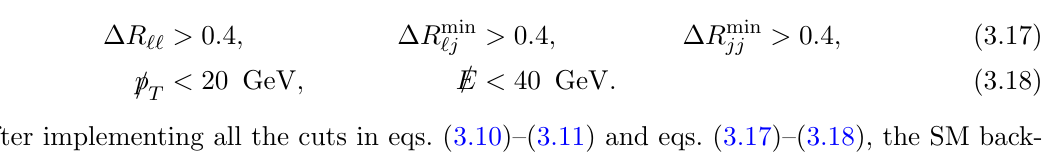
Figure 10 . Total cross section for the process e + e (cid:0) ! N(cid:22) (cid:6) W (cid:7) ! (cid:22) (cid:6) (cid:22) (cid:6) + 4 j after all the cuts in eqs. (3.10){(3.11) and eqs. (3.17){(3.18) at the 1 TeV ILC, with S (cid:22)(cid:22) = 10 (cid:0) 4